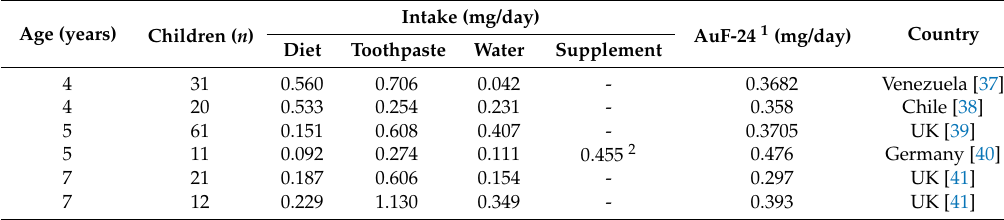
Table 1. Fluoride intake and urinary fluoride measured in the studies were selected to validate the model. Age